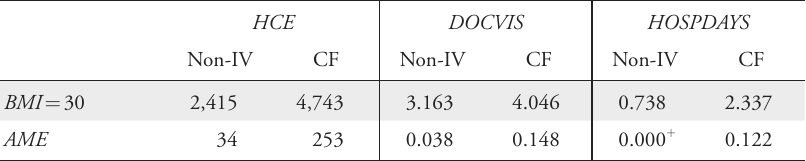
Table 3: Predicted Means at BMI=30 and Average Marginal